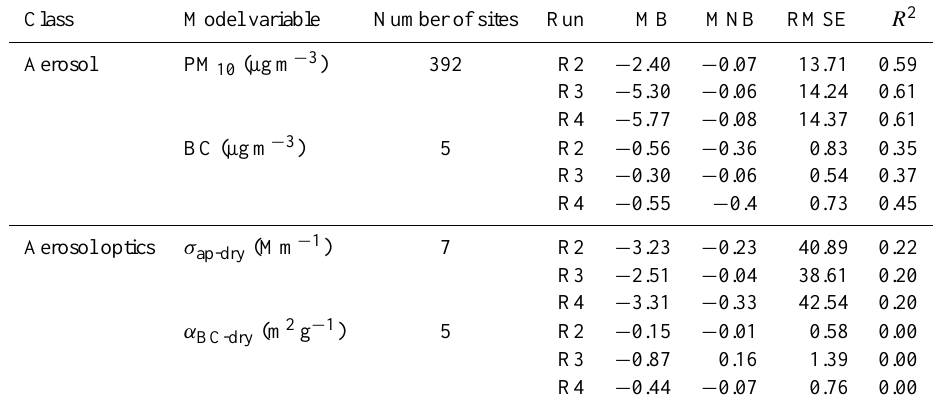
Table 5. Summary of values of mean bias (MB), mean normalized bias (MNB), root mean square error (RMSE) and coefficient of deter- mination ( R 2 ) derived from a comparison of different measurements and corresponding model values simulated in the runs R2, R3 and